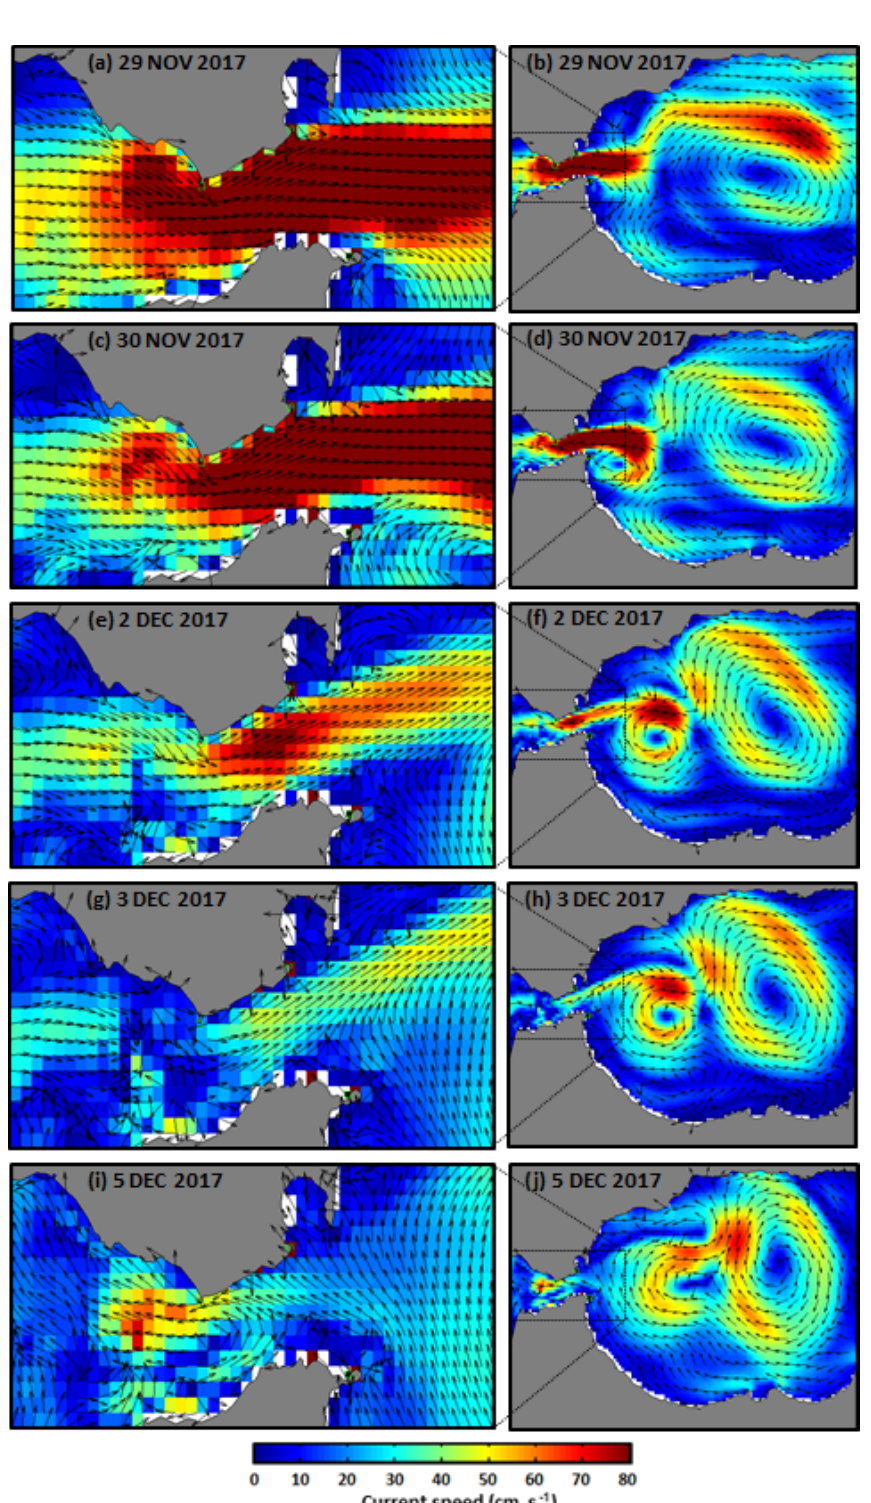
Figure 13. Sequence of SAMPA daily surface circulation maps covering the period from 29 November to 5 December 2017. General map on the right and zoom over the Strait of Gibraltar on the left. An inflow reversal through the narrowest section of the Strait of Gibraltar is evidenced on 5 December, as a result of a change in the wind regime, from westerlies to